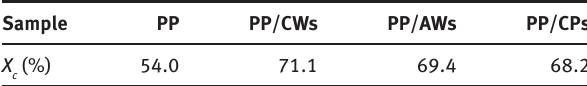
Table 2: Crystallinity data obtained by XRD measurements for neat PP and composites filled with 5 wt% CWs, AWs,